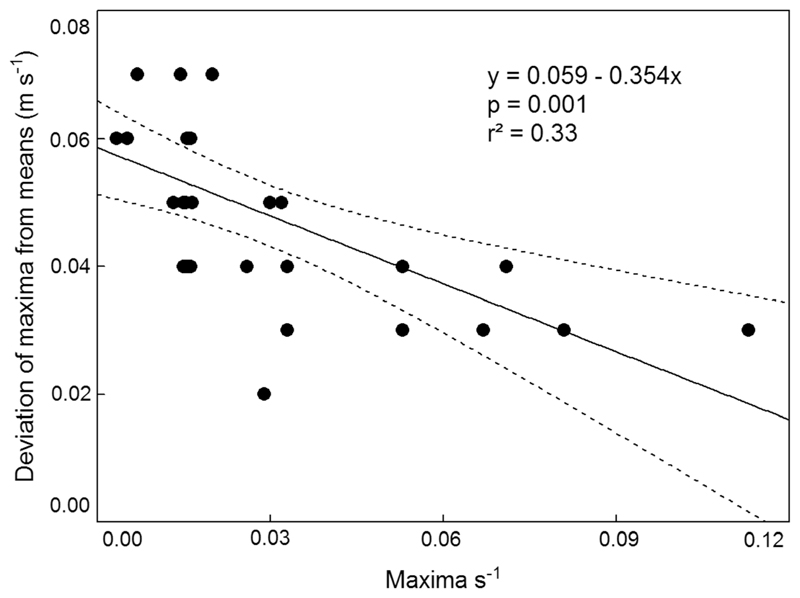
Relationship between the frequency of flow velocity maxima s−1 for each spatio-temporally filtered data series and the deviation of flow velocity maxima from mean flow velocity of the respective data series; showing linear regression line and 95% CL confidence bands